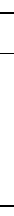
Table 2. The influence of isoflavones on Saos-2 cells viability presented as IC 50 values after 14 days incubation. The influence of tested compounds was measured with PrestoBlue assay, values are means from at least three independent experiments ( n ≥